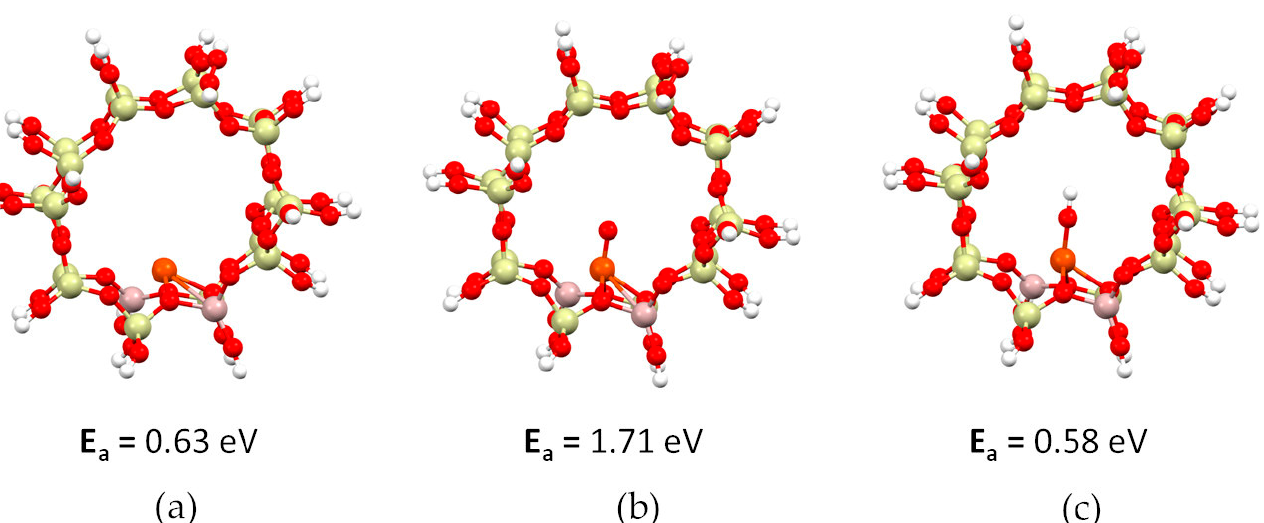
Figure 1. Structure with iron adsorbates inside the pore (energy of adsorption below the structure): ( a ) ZSM-5 with iron, ( b ) ZSM-5 with iron oxide, and ( c ) ZSM-5 with iron hydroxide. Atoms’ color: iron—orange, aluminum—pink, silicon—yellow, oxygen—red, hydrogen—white.